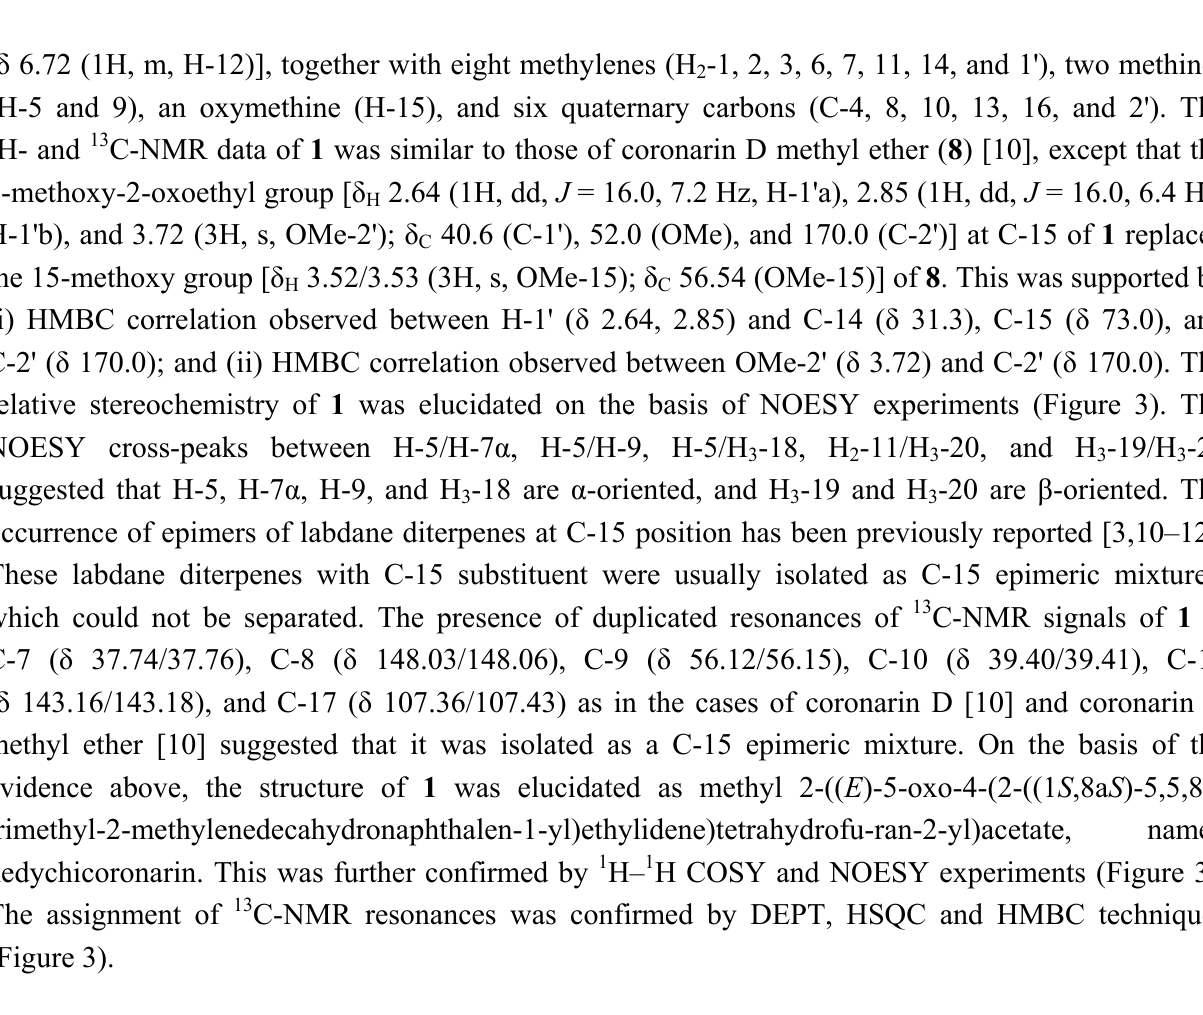
Figure 3. Key NOESY (3a) and HMBC (3b) correlations of 1